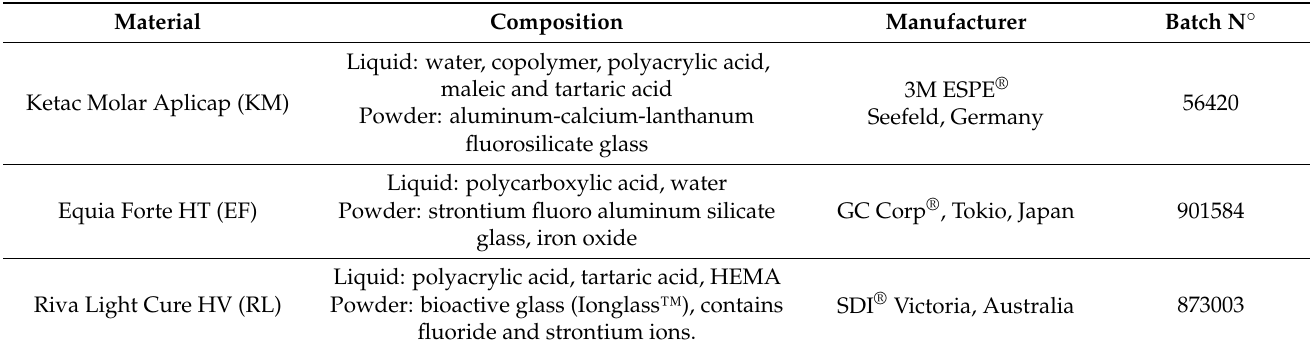
Table 1. Composition, manufacturer, and batch number of the studied